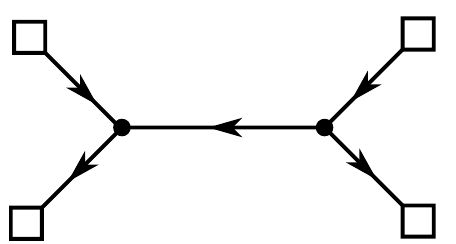
Figure 1 . Diagrammatic representation of the gauge theory corresponding to table